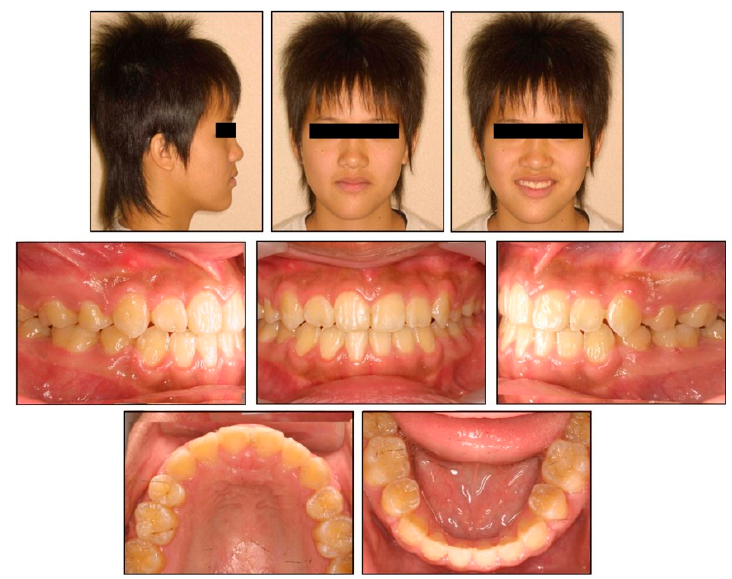
Figure 5. Case 1, Posttreatment facial and intraoral photographs.